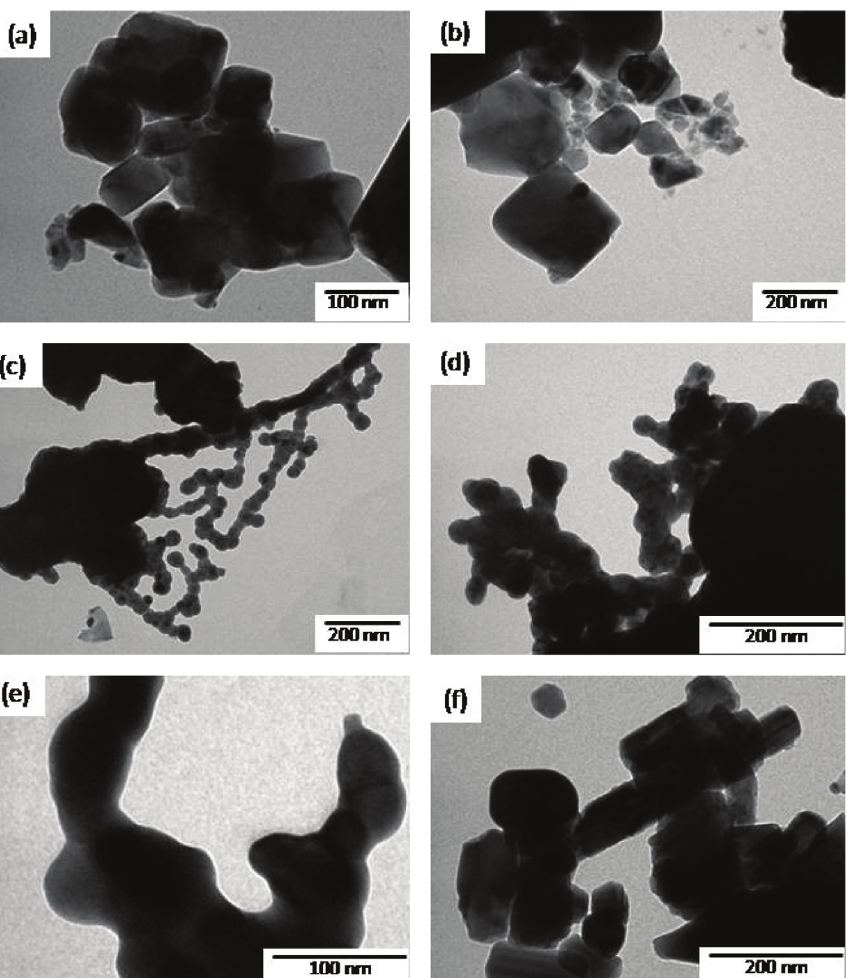
Figure 6: Different magnification TEM images of Ba 0.85 Sm 0.1 TiO 3 nanostructures as function of annealing temperature: (a – b) 700°C, (c – d) 800°C and (e – f)